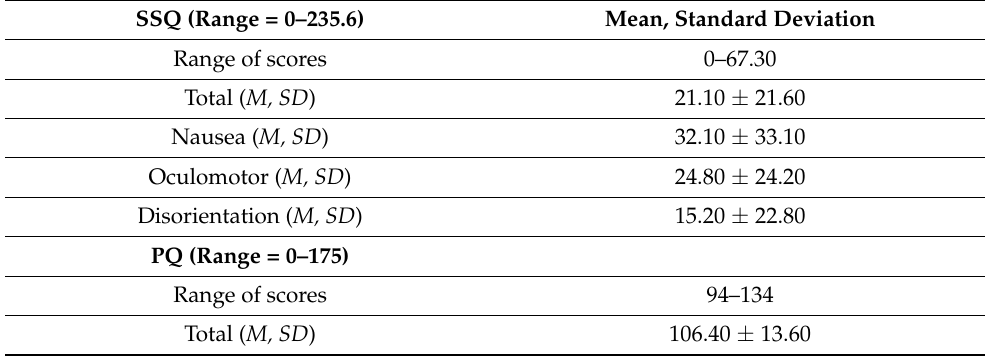
Table 2. Acceptability